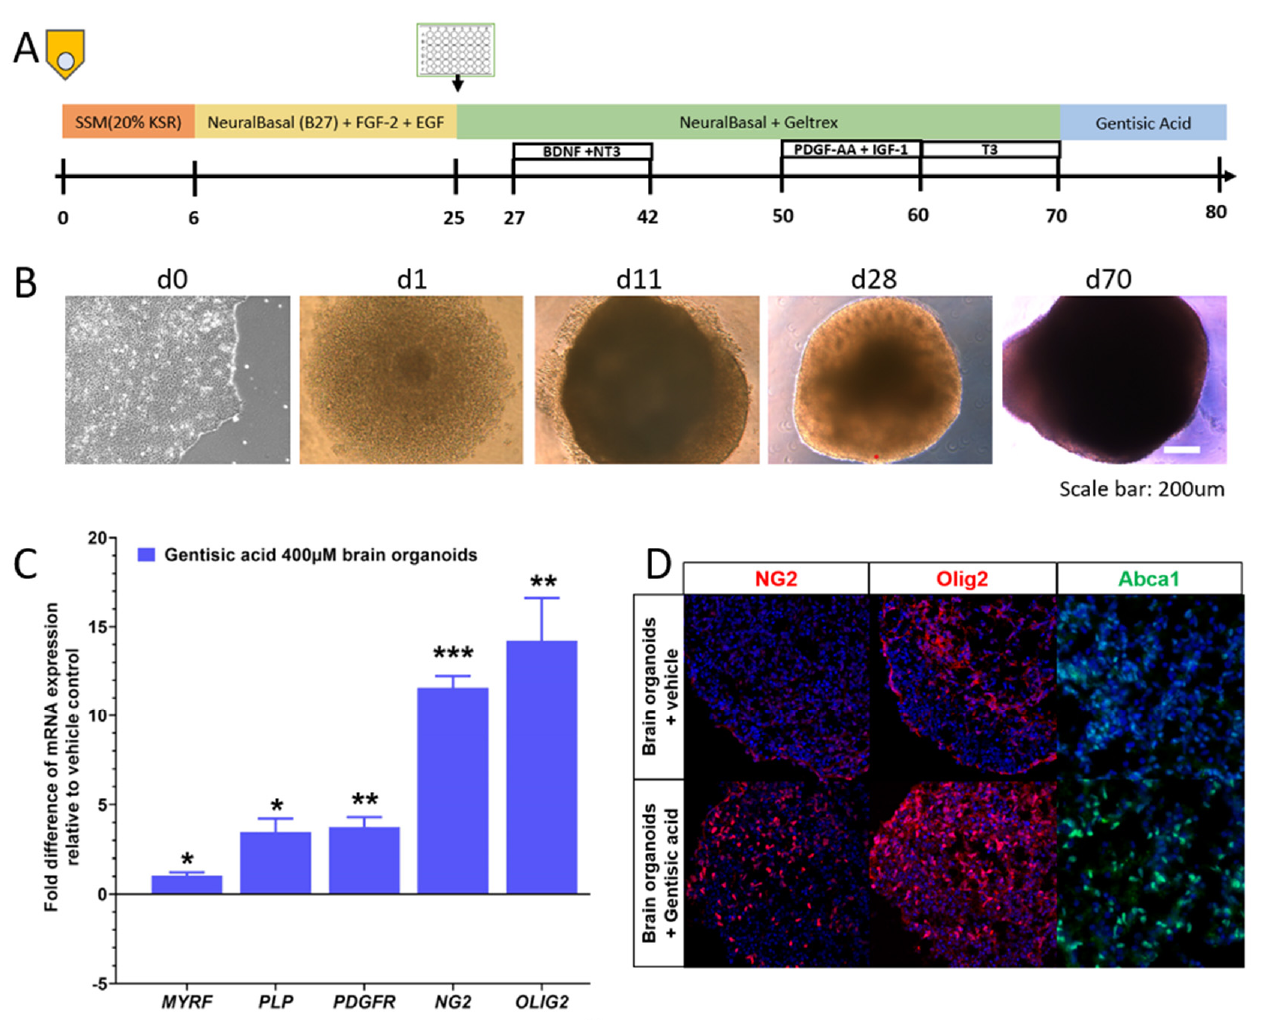
Figure Figure 2. Gentisic acid (GA) supplementation accelerates myelination in brain organoids: ( A ) Sche- matic representation of the timeline of brain organoid generation, including GA application at days 70–80. ( B ) Representative brightfield images document progression of organoid growth from iPSC to brain organoids. ( C ) RT-PCR analysis demonstrates significantly increased expression of oli- godendrocyte (precursor) cell markers ( NG2, OLIG2 , and PDGFR ) and genes related to myelin for-